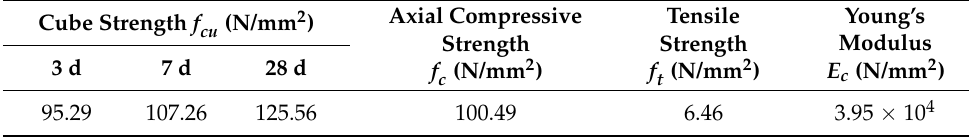
Figure 7. RPC material sample. ( a ) Compressive; ( b ) Uniaxial compressive; ( c ) Tension. Table 3. Mechanical performance test results of RPC.